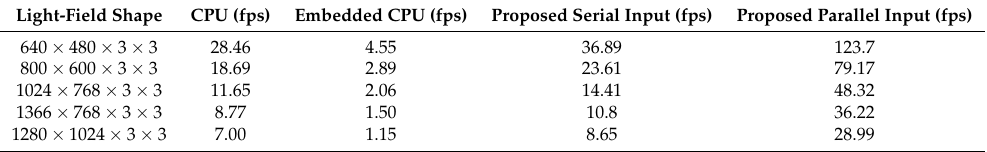
Table 7. Frame rates for serial and parallel input designs.